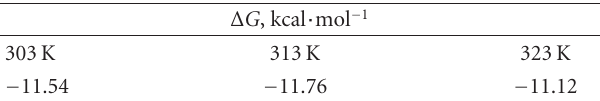
Table 5: The free energy of adsorption ( Δ G ads ) for mild steel in 1M HCl in the presence of trans-4-hydroxy-4 (cid:2) -stilbazole inhibitor at various temperatures (303K–323K).